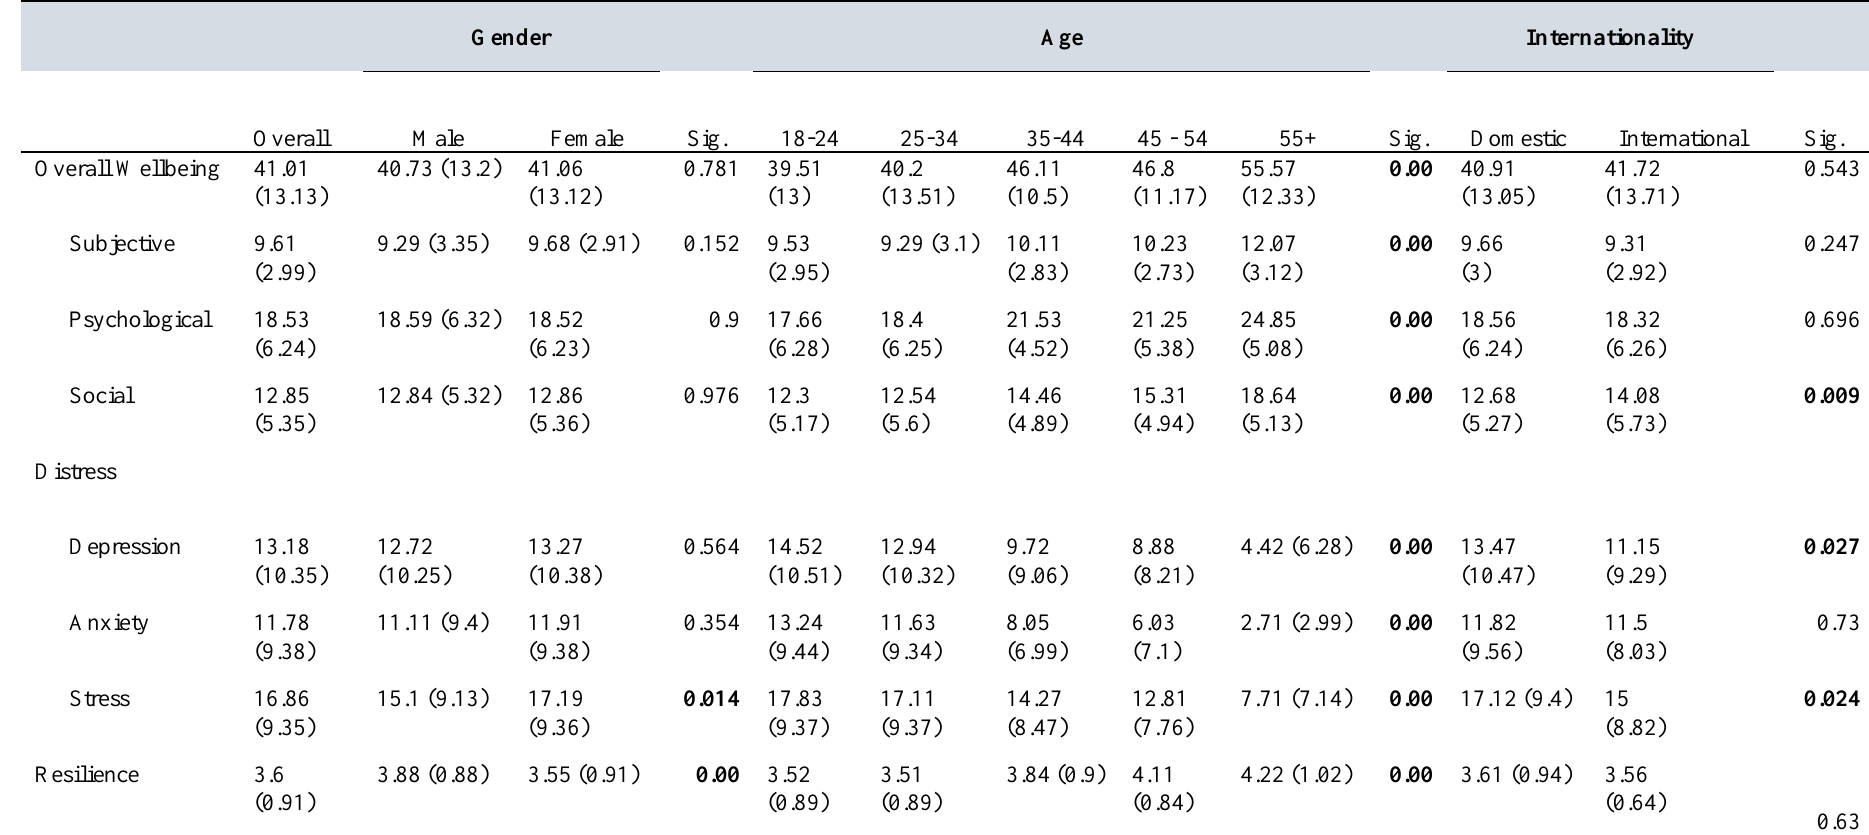
Unadjusted mean scores and standard deviations (in brackets) for all domains, overall and split for gender, age, internationality. Significance values are reported next to each sub-group with significance (displayed in